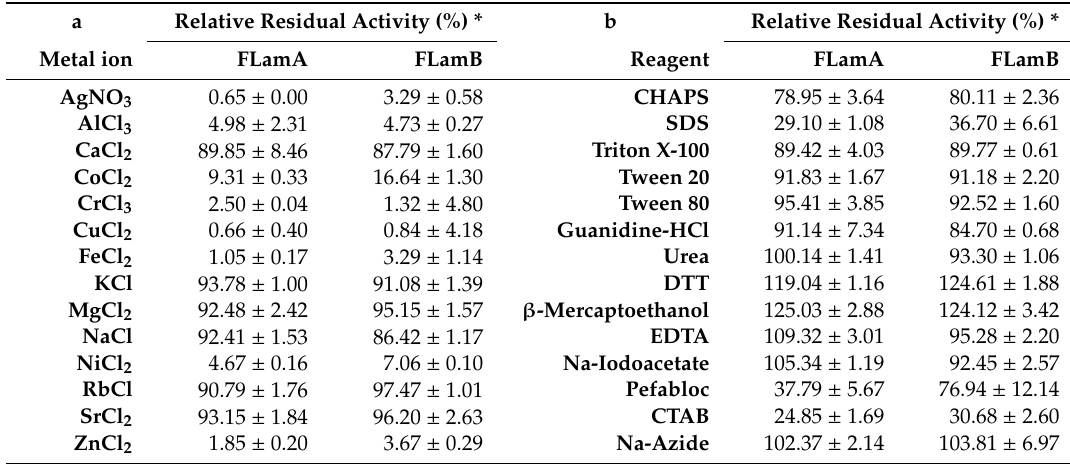
Table 2. Influence of metal ions ( a ) and di ff erent reagents ( b ) on laminarinase activity of FLamA and